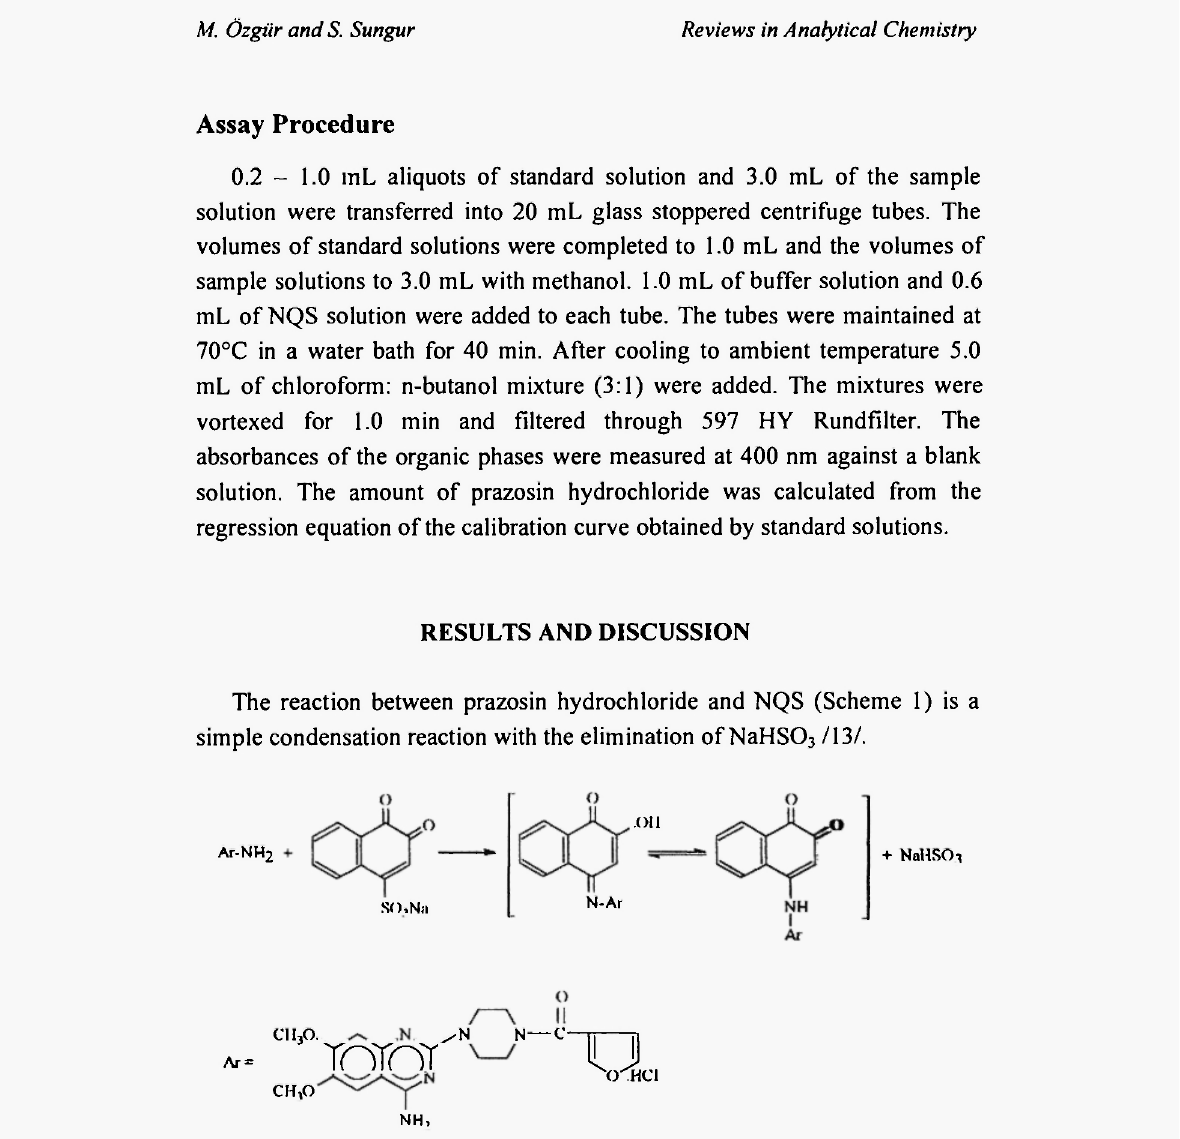
Scheme 1: Reaction of prazosin hydrochloride (1) with